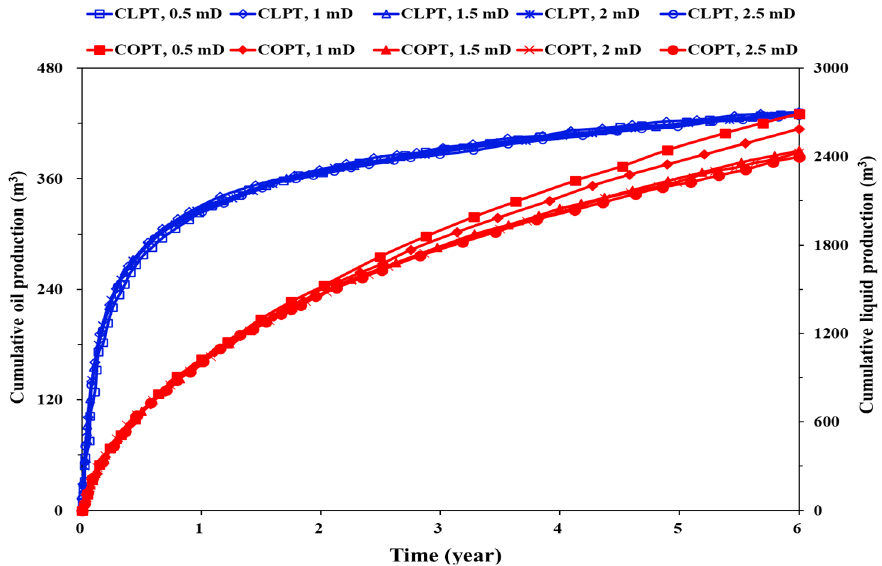
Figure 17. Production performance curves with different formation permeability values (6 years of production).